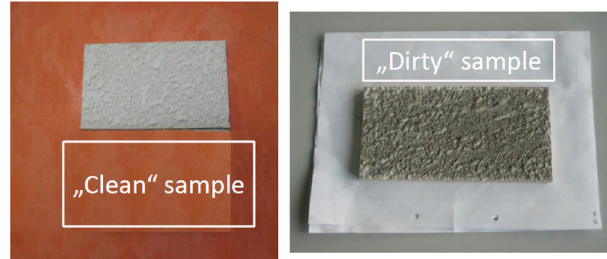
Figure 58. Sample of a photoactive TiO 2 -based cementitious surface before and after one week in the Leopold II tunnel in Brussels. Courtesy of Dr. Falk Mothes of the Leibnitz Institute for Tropospheric Research (TROPOS), Germany.